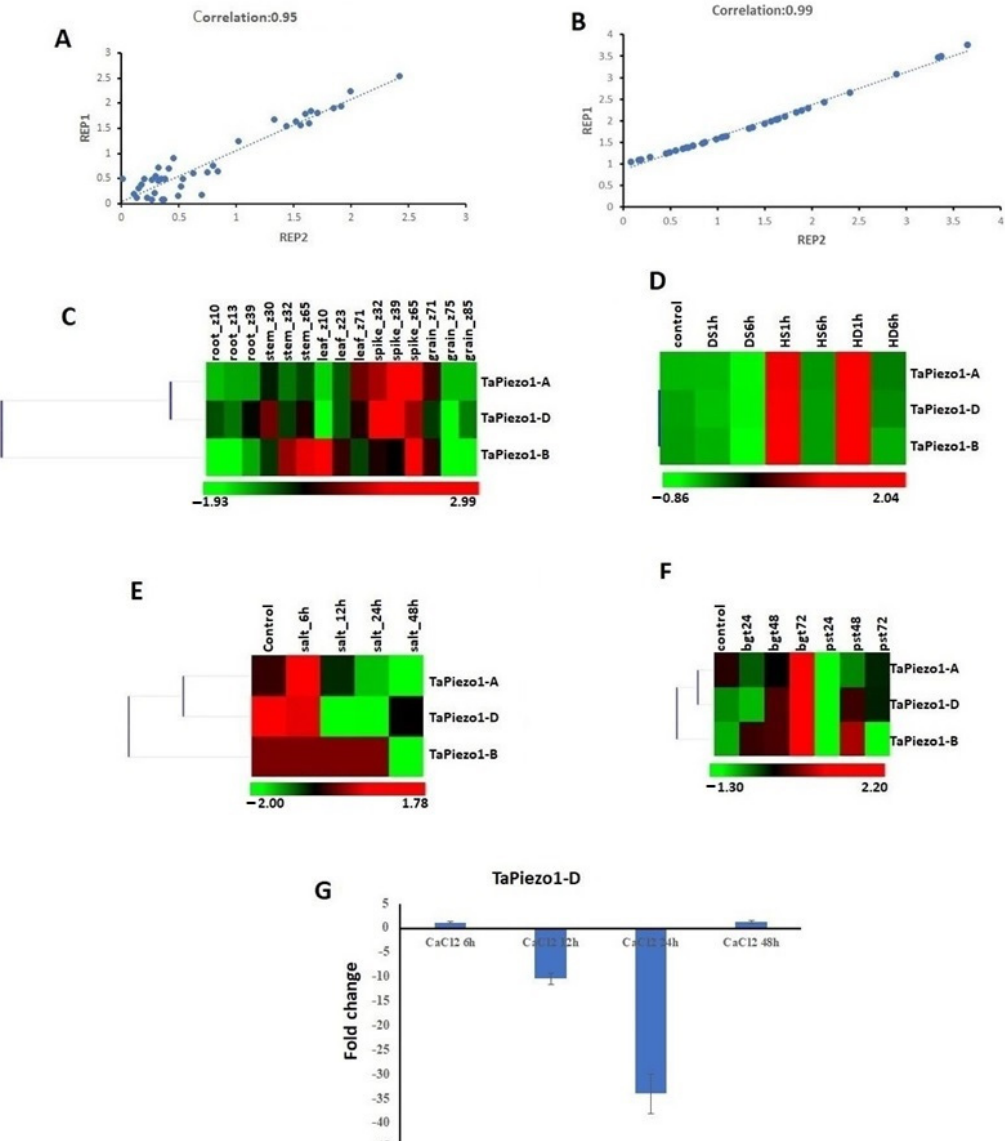
Figure 6. Correlation, expression and qRT-PCR analysis. Figure shows correlation analyses between replicates of expression data in ( A ) tissue developmental stages and ( B ) stress conditions. Heat map ( C ) shows the clustering and expression profiling TaPiezo genes in tissue developmental stages. The Heat maps ( D – F ) show the expression profile of TaPiezo genes under ( D ) drought stress, heat stress, and heat–drought stress, ( E ) salt stress and ( F ) during the treatment of Blumeria graminis (Bgt) and Puccinia striiformis (Pst), respectively. The low and high expressions are represented by green and red colors, respectively, in the color bar. Graph ( G ) shows the qRT-PCR results of TaPiezo1-D under CaCl 2 stress at 6, 12, 24, and 48 h of treatments. The bar graphs indicate the fold change in TaPiezo1-D gene expression under treatments as compared to the control condition.